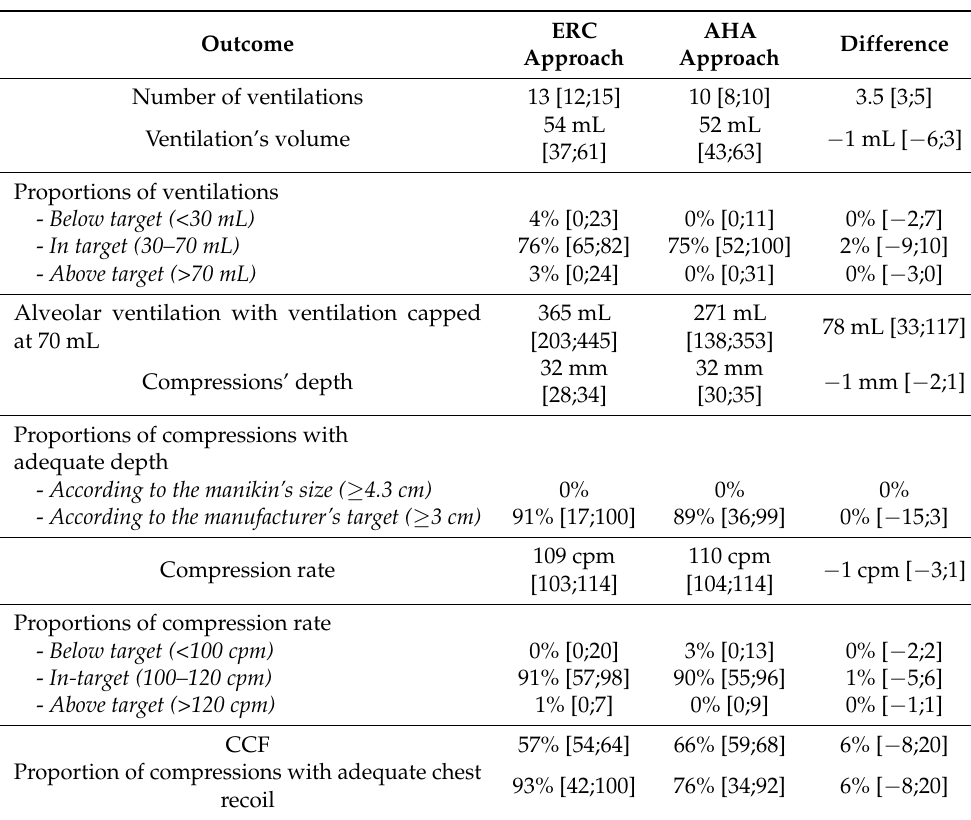
Table 2. Secondary outcomes, expressed as median [Q1;Q3].